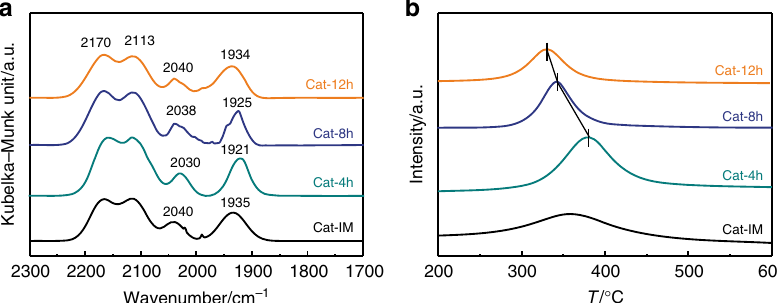
Fig. 6 Interaction between CO and the reduced catalysts. a In situ DRIFTS spectra of CO adsorption on the reduced catalysts. b CO-TPD/MS pro fi les of the reduced